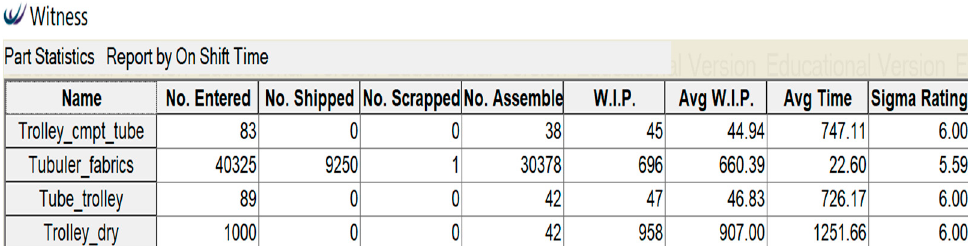
Figure 5. Mapped process output in the WITNESS simulation platform.